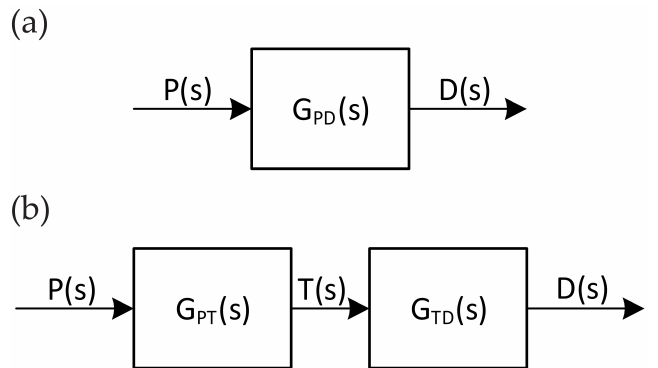
Figure 22. Models of the object developed for the needs of both analyzed variants for controlling the dryness of a cotton tape: for classic PID-type controller ( a ) and for cascade controller ( b ), where P is the heating power (W), D is the dryness of the material tape (%), T is the surface temperature of the cylinder ( ◦ C), G is the operator transmittance, and t is time (s).